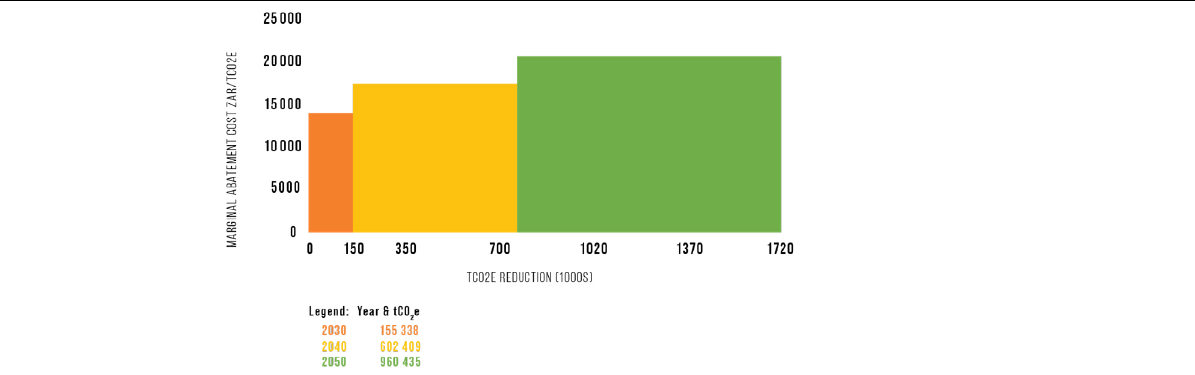
Figure 4: Marginal abatement cost curve for distributed renewable energy supply in 2030, 2040, and